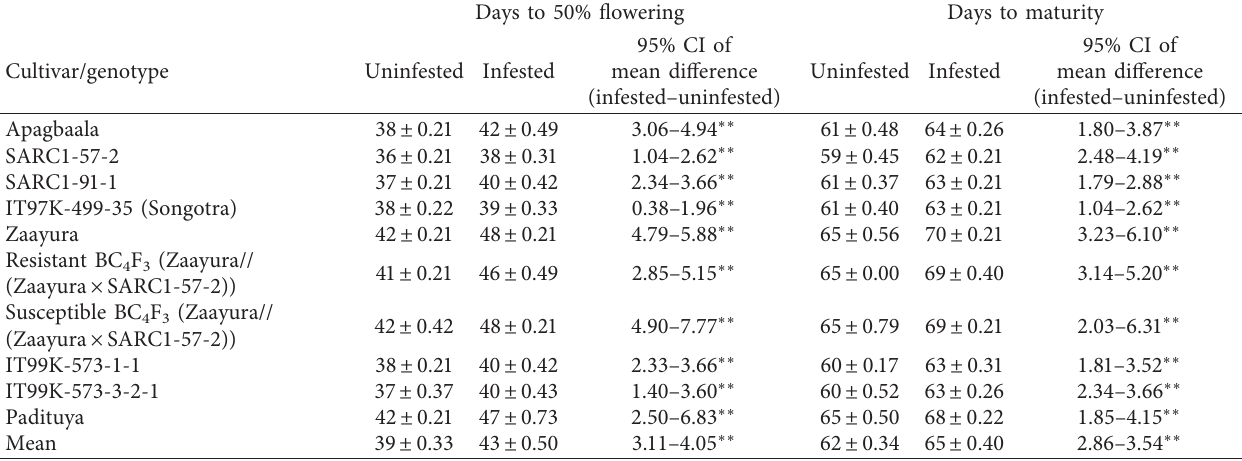
Table 4: Effect of seedling stage aphid infestation on number of days to flowering and maturity.